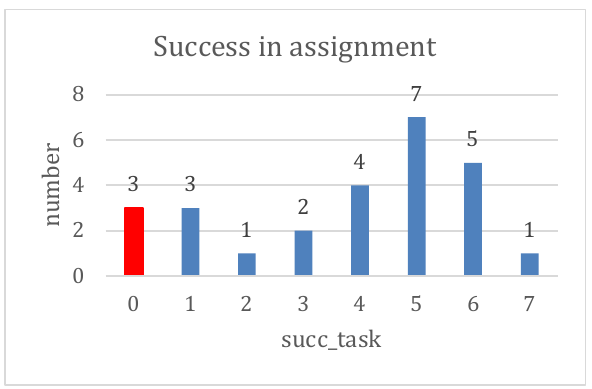
Fig. 2 Plot of the distribution of the number of students whose successfully solved tasks The red column in Figure 2 stands for the students who have not completed even one task correctly.